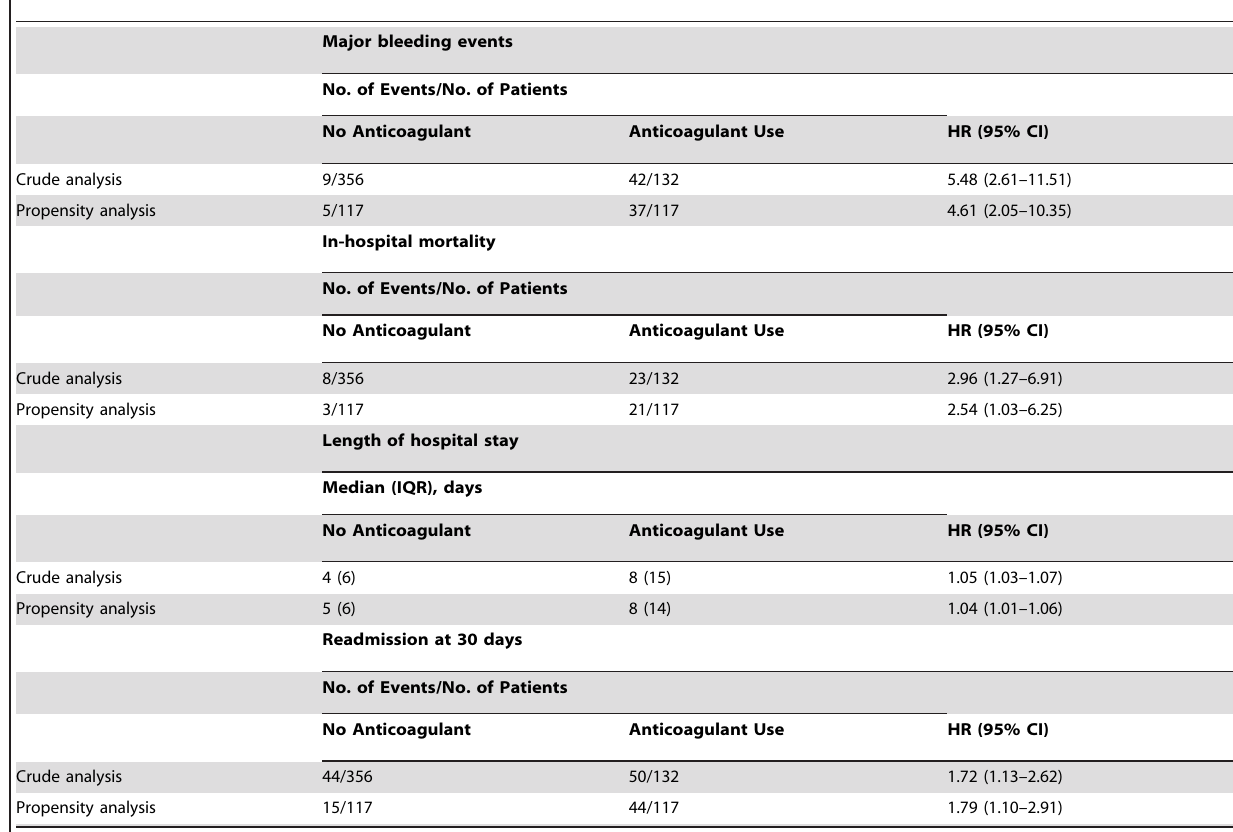
Table 3. Crude and propensity adjusted hazard ratios of anticoagulant-related adverse outcomes.